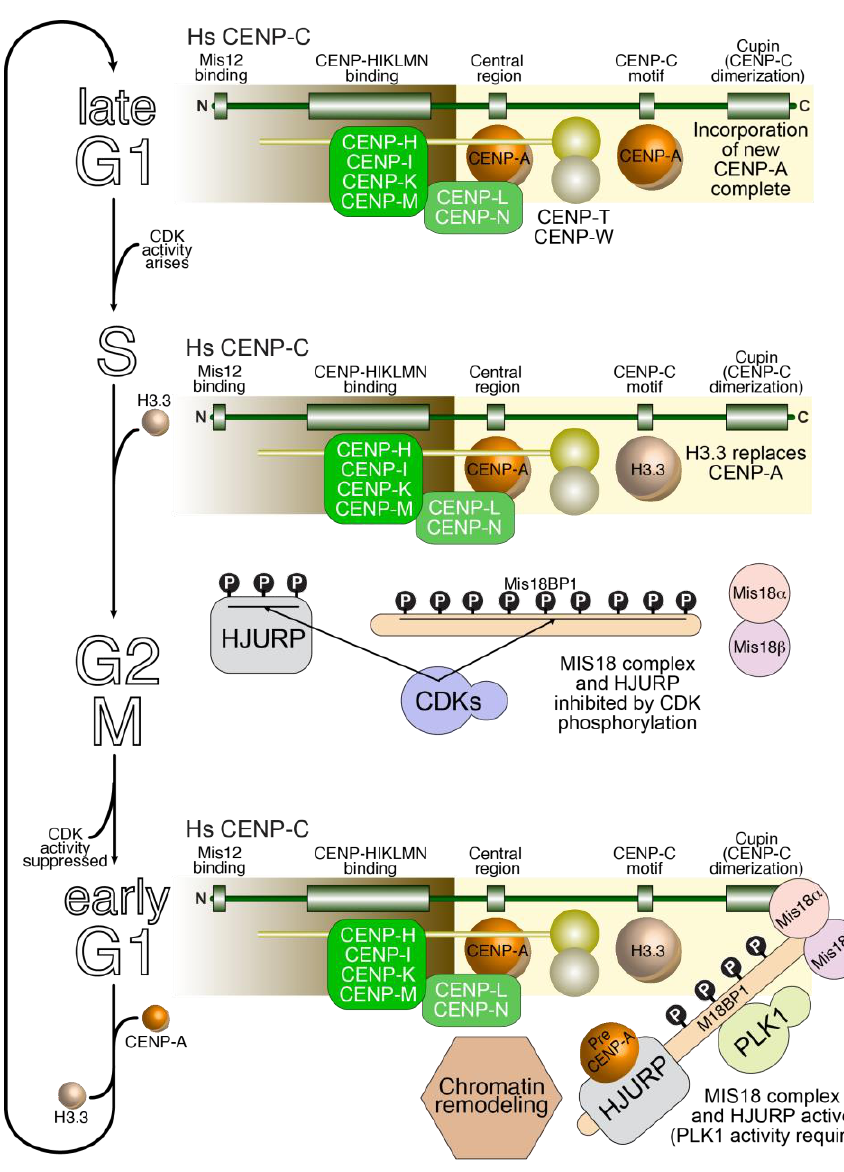
Figure 9. Cell cycle-regulated replenishment of CENP-A nucleosomes New. CENP-A incorporation takes place after mitotic exit, early in G1 phase ( bottom ). It is driven by an existing, active CENP-A nucleosome (e.g., because bound to CCAN subunits), and directed on a neighboring nucleosome. Here, we hypothesize that the neighboring nucleosome in humans is already bound to the CENP-C motif of CENP-C. An active MIS18 complex, including M18BP1, recruits HJURP, which binds to pre-nucleosomal CENP-A. The C-terminal region of CENP-C has been implicated in this reaction, which also requires PLK1 activity. A chromatin-remodeling factor and other chromatin-associated factors promote extraction of H3.3 and its replacement with CENP-A through an ATP-dependent reaction. The resulting configuration ( top ) persists until DNA replication (S-phase), when CENP-A “vacancies” caused by distribution of CENP-A to the sister chromatids during DNA replication, are filled with H3.3. This configuration then persists through the rest of the cell cycle until mitotic exit, because the CENP-A loading machinery is inhibited by CDK activity ( middle ).